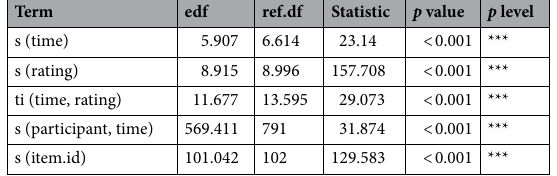
Table 9. Summary output for the basic GAMM modelling participants’ pupil sizes in response to socio- cultural violations.